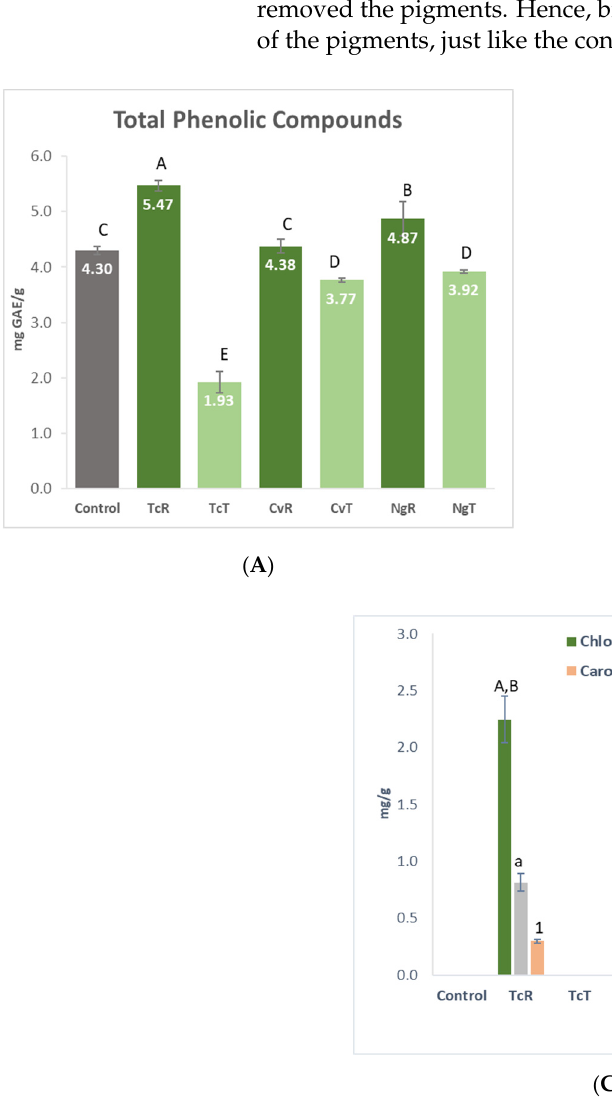
Figure 5. Measurement of the antioxidant capacity using total phenols ( A ), DPPH ( B ), and pigments ( C ) in the given gluten-free breads enriched with Tetraselmis chuii (TcR), Tetraselmis chuii ethanol- treated (TcT), Chlorella vulgaris (CvR), Chlorella vulgaris ethanol-treated (CvT), Nannochloropsis gaditana (NgR) and Nannochloropsis gaditana ethanol-treated (NgT). Totality dark refers to control (A and B). Values represent mean ± stdev (n = 3). Different letters for a given parameter indicate a significant difference ( p > 0.05) using a Fisher LSD test. Significant differences in chlorophyll a, chlorophyll b, and carotenoids are shown by capital letters, small letters, and numbers, respectively.